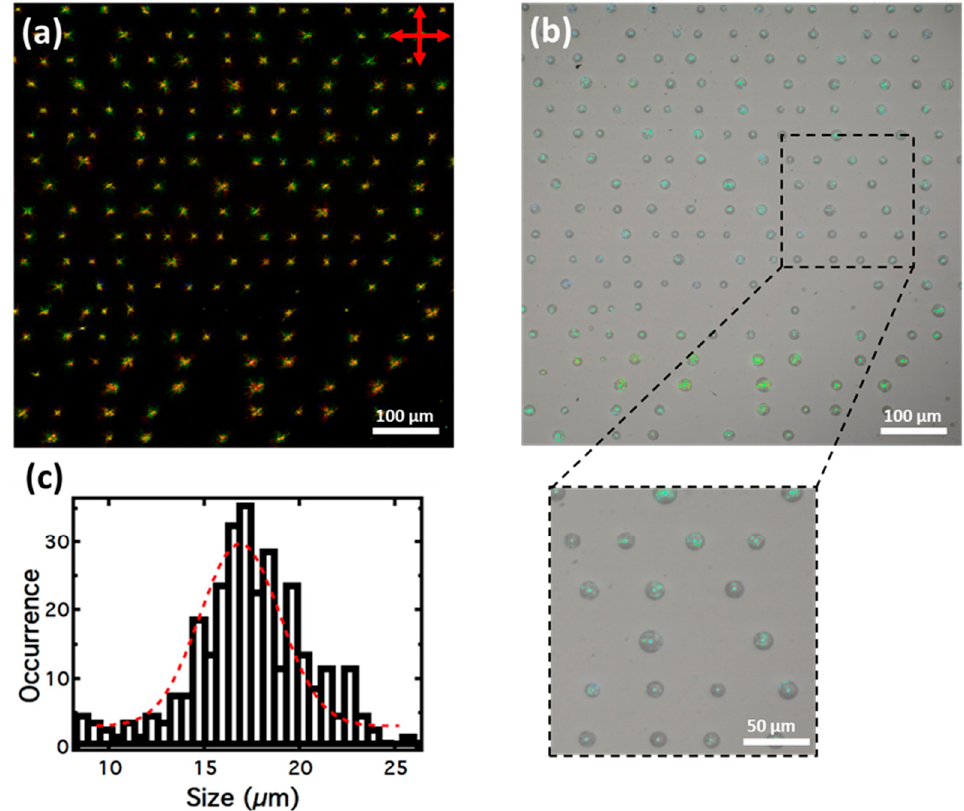
Figure 13. The effect of adding water to the stripes of the LC E7 containing 8.2% of the chiral dopant S1011 shown in Figure 13. ( a ) Transmission mode, crossed polarisers. ( b ) Bright ‐ field image taken in reflection mode. ( c ) Size distribution of the droplets.